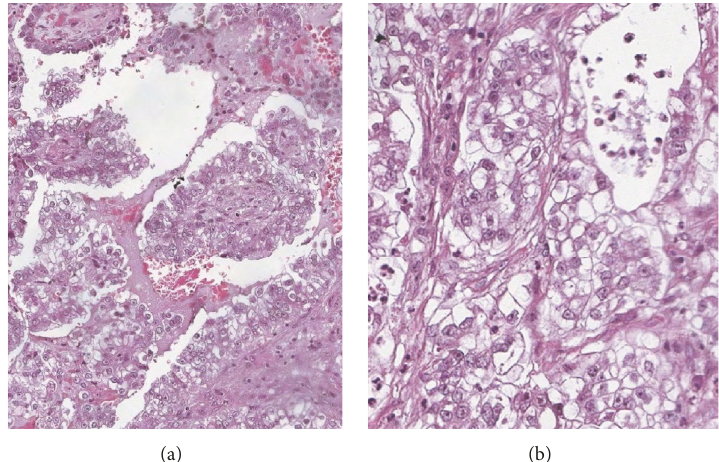
Figure 4: Microscopicexamination displays thepapillary growth structureslined by roundtumor cells with clear cytoplasm and pleomorphic nucleoli (4x(a) and 10x (b)).